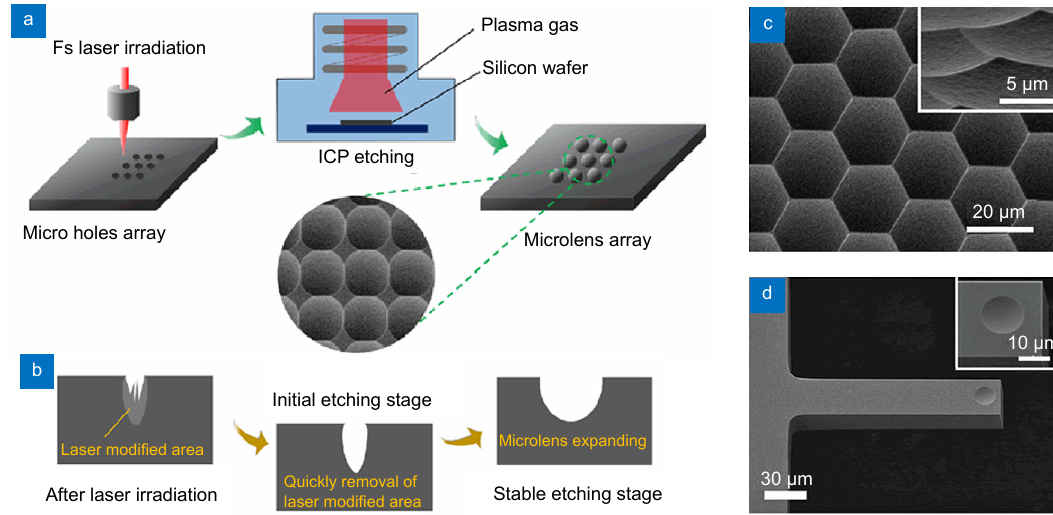
Fig. 8 | Fabrication of silicon concave microlens arrays by dry-etching-assisted femtosecond laser modification. ( a ) Diagram of fabrication of silicon microlens arrays. ( b ) Diagram of the evolution of the microlens formation. ( c ) SEM of the closely packed silicon concave microlens arrays. ( d ) SEM of microlens integrated on the micro-cantilever. Figure reproduced from (a–d) ref. 97 , WILEY-VCH Verlag GmbH & Co.